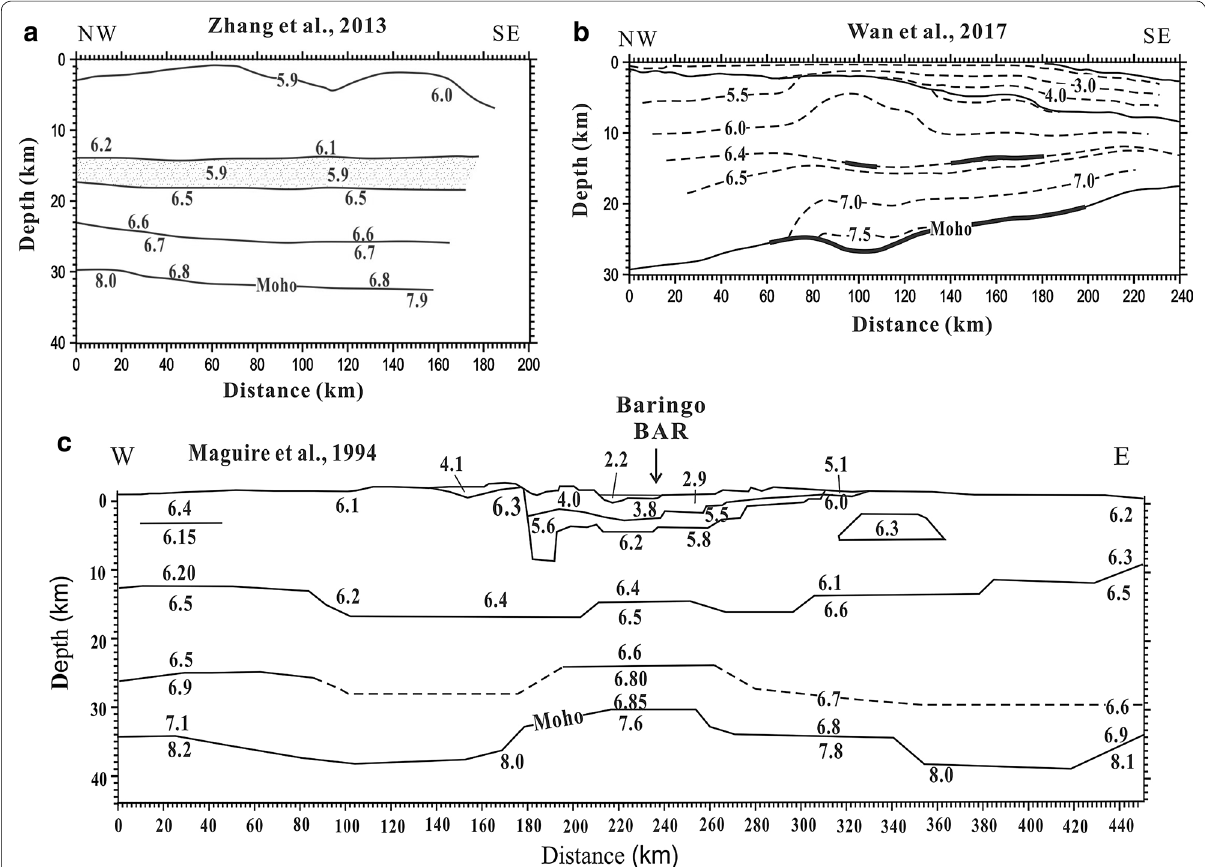
Fig. 17 P-wave velocity structure beneath south China ( a ) and the margin of the South China Sea ( b ). We merge these two crustal models a , b to make the composite section in Fig. 18a. c the P-wave velocity structure crossing Kenya Rift. Locations of these seismic profiles are indicated in Fig.